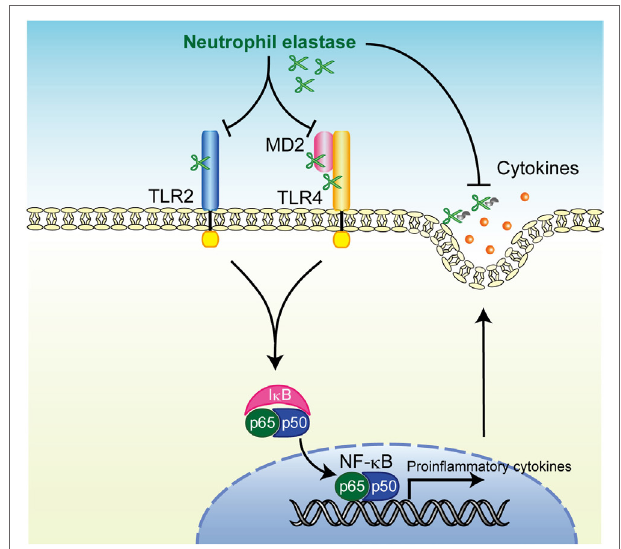
FigUre 7 | Summary of neutrophil elastase-induced suppression of toll-like receptor (TLR) signaling. Human neutrophil elastase (hNE) degrades TLRs and myeloid differentiation factor 2 (MD2) followed by inhibition of downstream signaling pathways including NF- κ B activation, which subsequently downregulates cytokine gene transcription. hNE also degrades secreted cytokines and eventually impairs the host innate immune